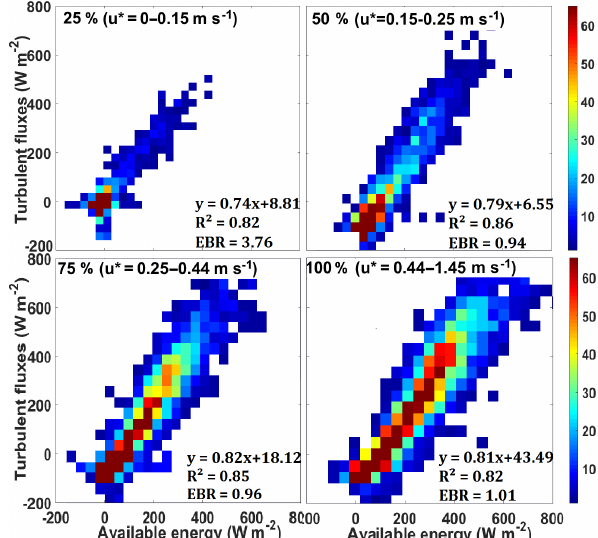
Figure 5. OLS and EBR evaluations at different friction velocity sorted at four quartiles. The colour bar represents the count of EBR values. The colour bars represent the count of EBR